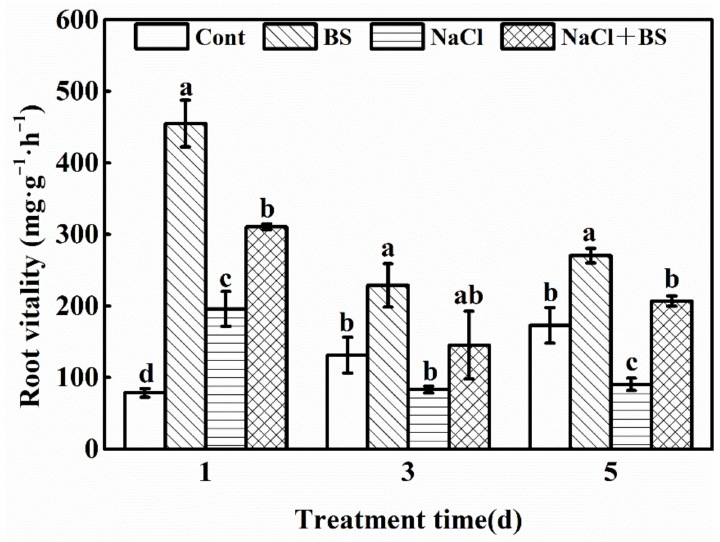
Figure 3. Effect of B. cereus on the root vitality of cucumber seedlings under salt stress. Bars represent standard errors. Different letters indicate a significant difference in the same parameter between treatments at p < 0.05.